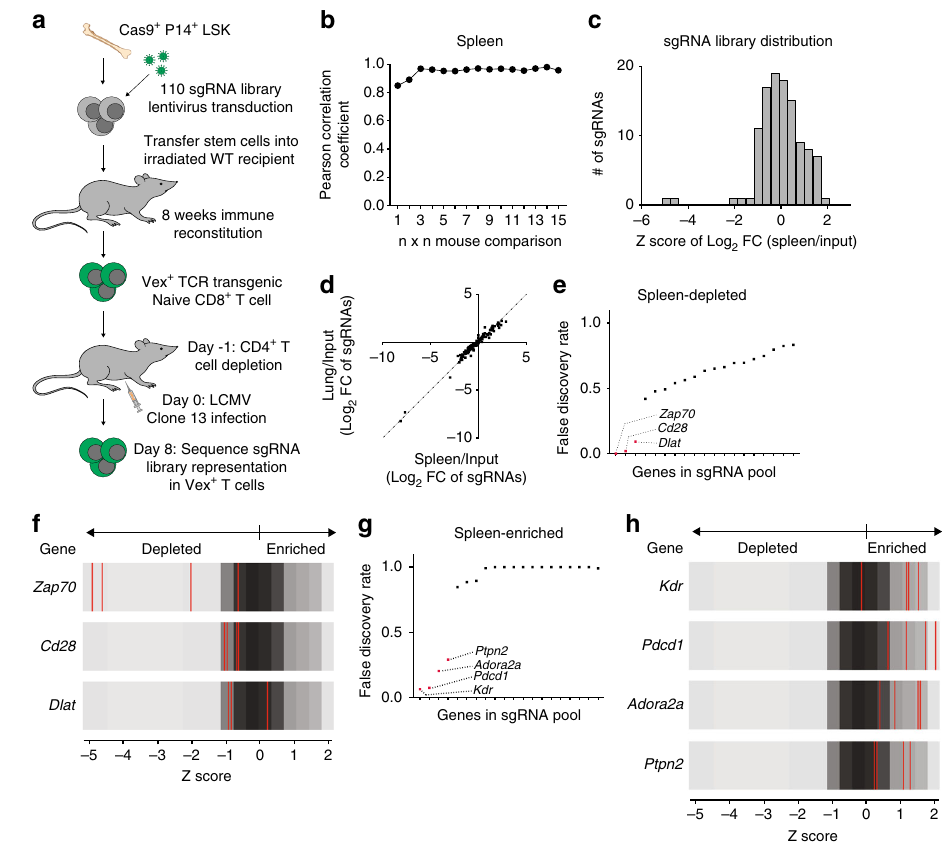
Fig. 4 In vivo screening identi fi es regulators of CD8 + T cell responses to LCMV. a Schematic for in vivo screening. b Plot of Pearson R correlation vs. the number of replicate mice analyzed in the spleen from mice used in experiment in the screen. c Histogram depicting the distribution of the 110 sgRNAs relative to their log 2 fold change (spleen/input). d Correlation of lung/input log 2 fold change vs. spleen/input log 2 fold change. Dotted line depicts a perfect correlation ( y = x ). e Plot of the STARS calculated FDR for depleted in the spleen at day 8 post LCMV infection compared with input ( y -axis) vs. the genes in the screening library ( x -axis). Labeled genes are genes called as hits based on the FDR distribution. f Z-score plots of genes identi fi ed as depleted hits. Grey represents the background distribution of the library and red lines represent the four individual sgRNAs for the given genes. g Plot of the STARS calculated FDR for enriched in the spleen at day 8 post LCMV infection compared with input ( y -axis) vs. the genes in the screening library ( x -axis). Labeled genes are genes called as hits based on the FDR distribution. h Z-score plots of genes identi fi ed as enriched hits. Grey represents the background distribution of the library and red lines represent the four individual sgRNAs for the given genes. The in vivo screen had thirty biological replicate animals per group and is representative of one experiment. False discovery rate was assessed by the STARS software. See also Supplementary Fig. 3. Source data are provided as a source data fi